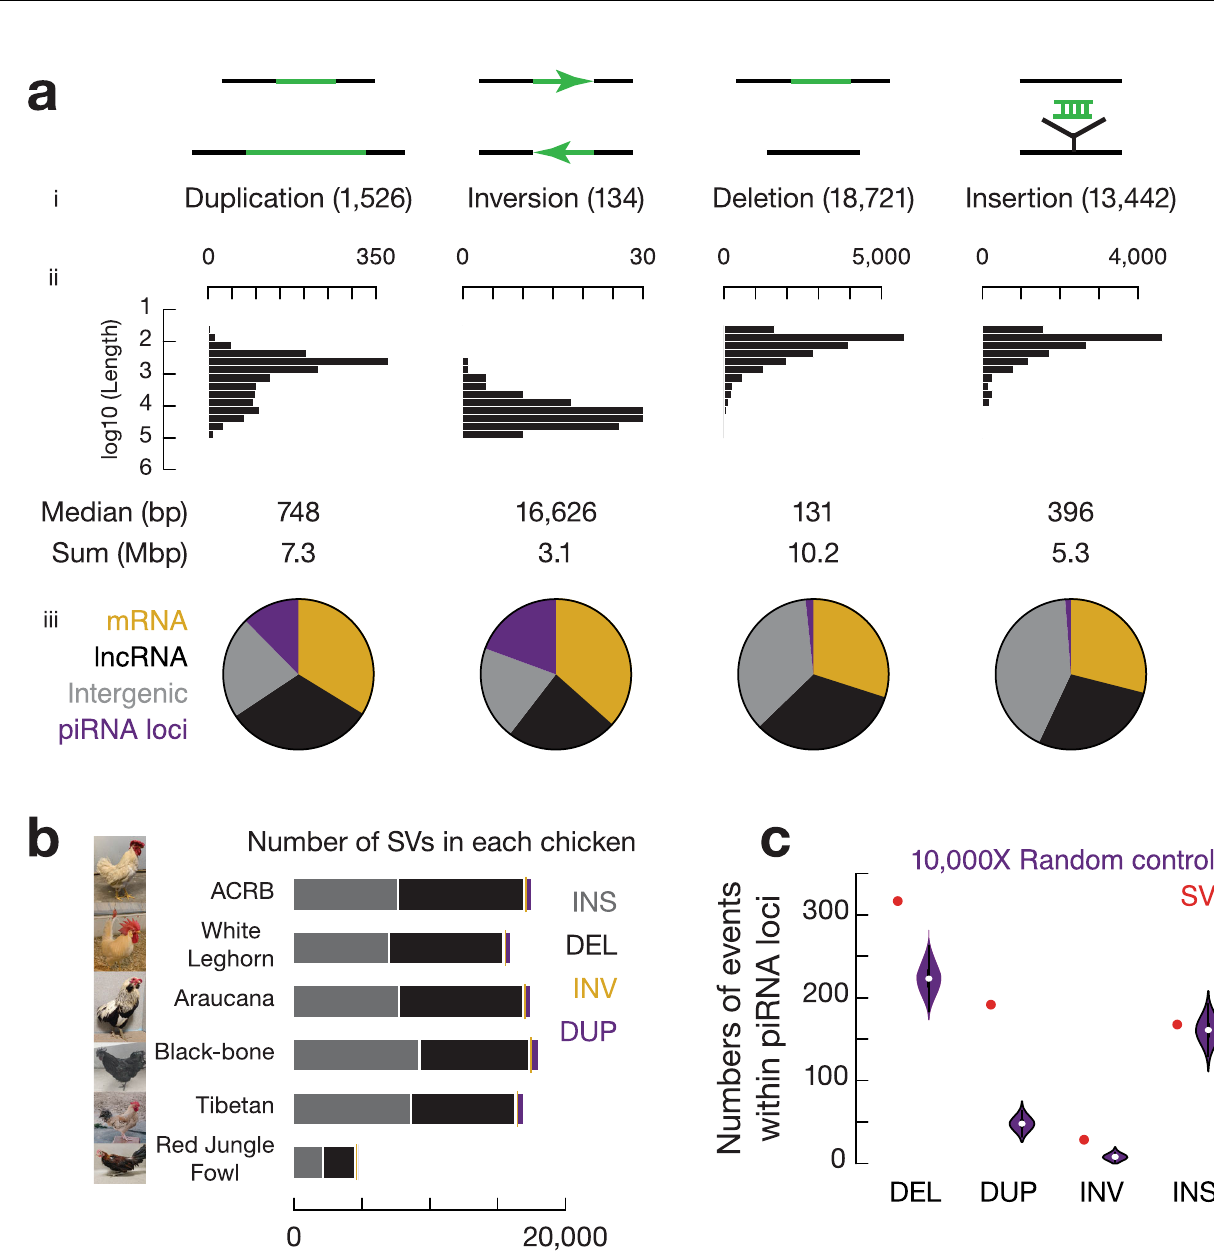
Fig.1|ExistenceofpachytenepiRNAsinchickens.a Roostersexpresspachytene piRNAs during spermatogenesis. (i) Key biological events during chicken sperma- togenesis. (ii)Length distributionof totalsmall RNAs. Ppm, parts per million. Blue, miRNAs. (iii) Abundance of piRNAs as measured by small RNA-seq. (iv) Expression of CIWI as measured byRNA-seq.Tpm, transcriptpermillion. b Immunolabeling of squashedpachytenespermatocytesfromadultchickentestesusinganti-CIWI,anti- SYCP1, and DAPI. Scale bar, 10 µ m. SYCP1, marker for synaptonemal complex